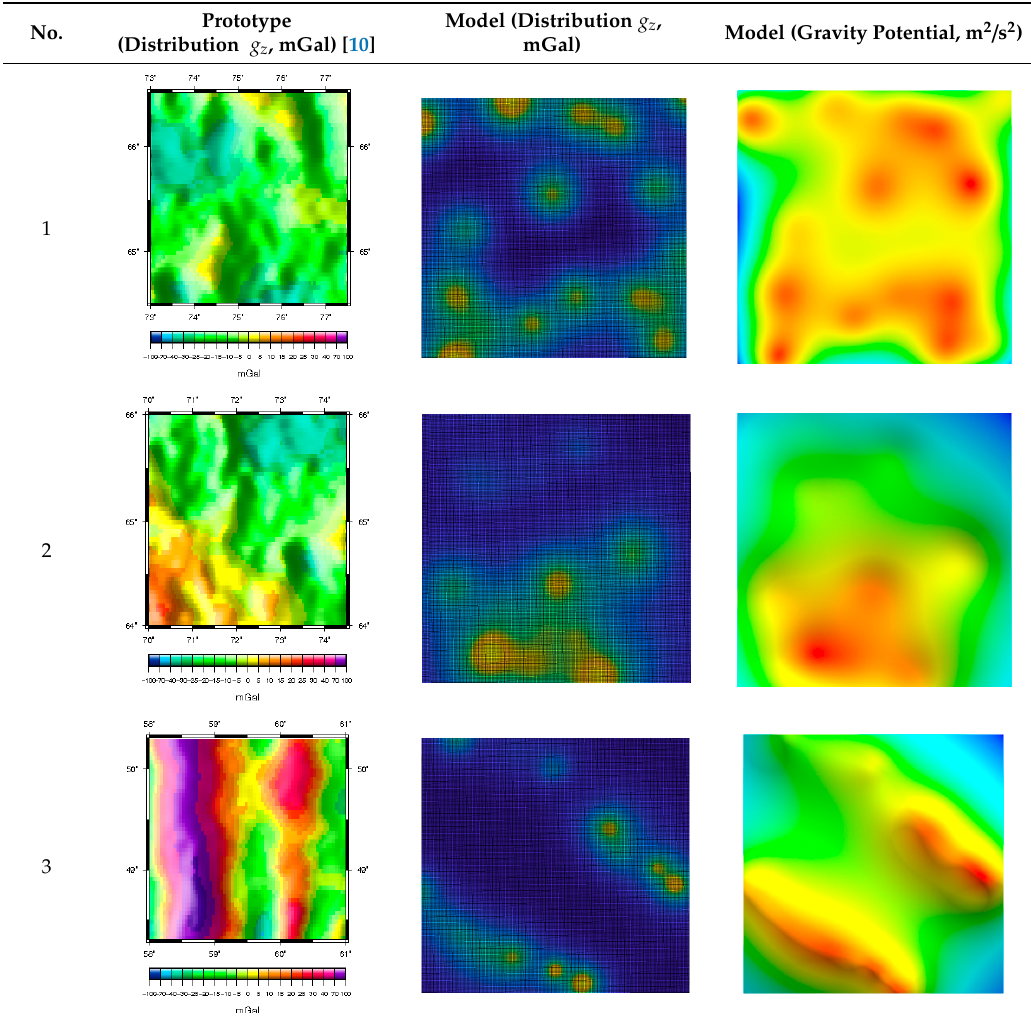
Table 1. Prototypes of the sites for building models and the corresponding distributions of the